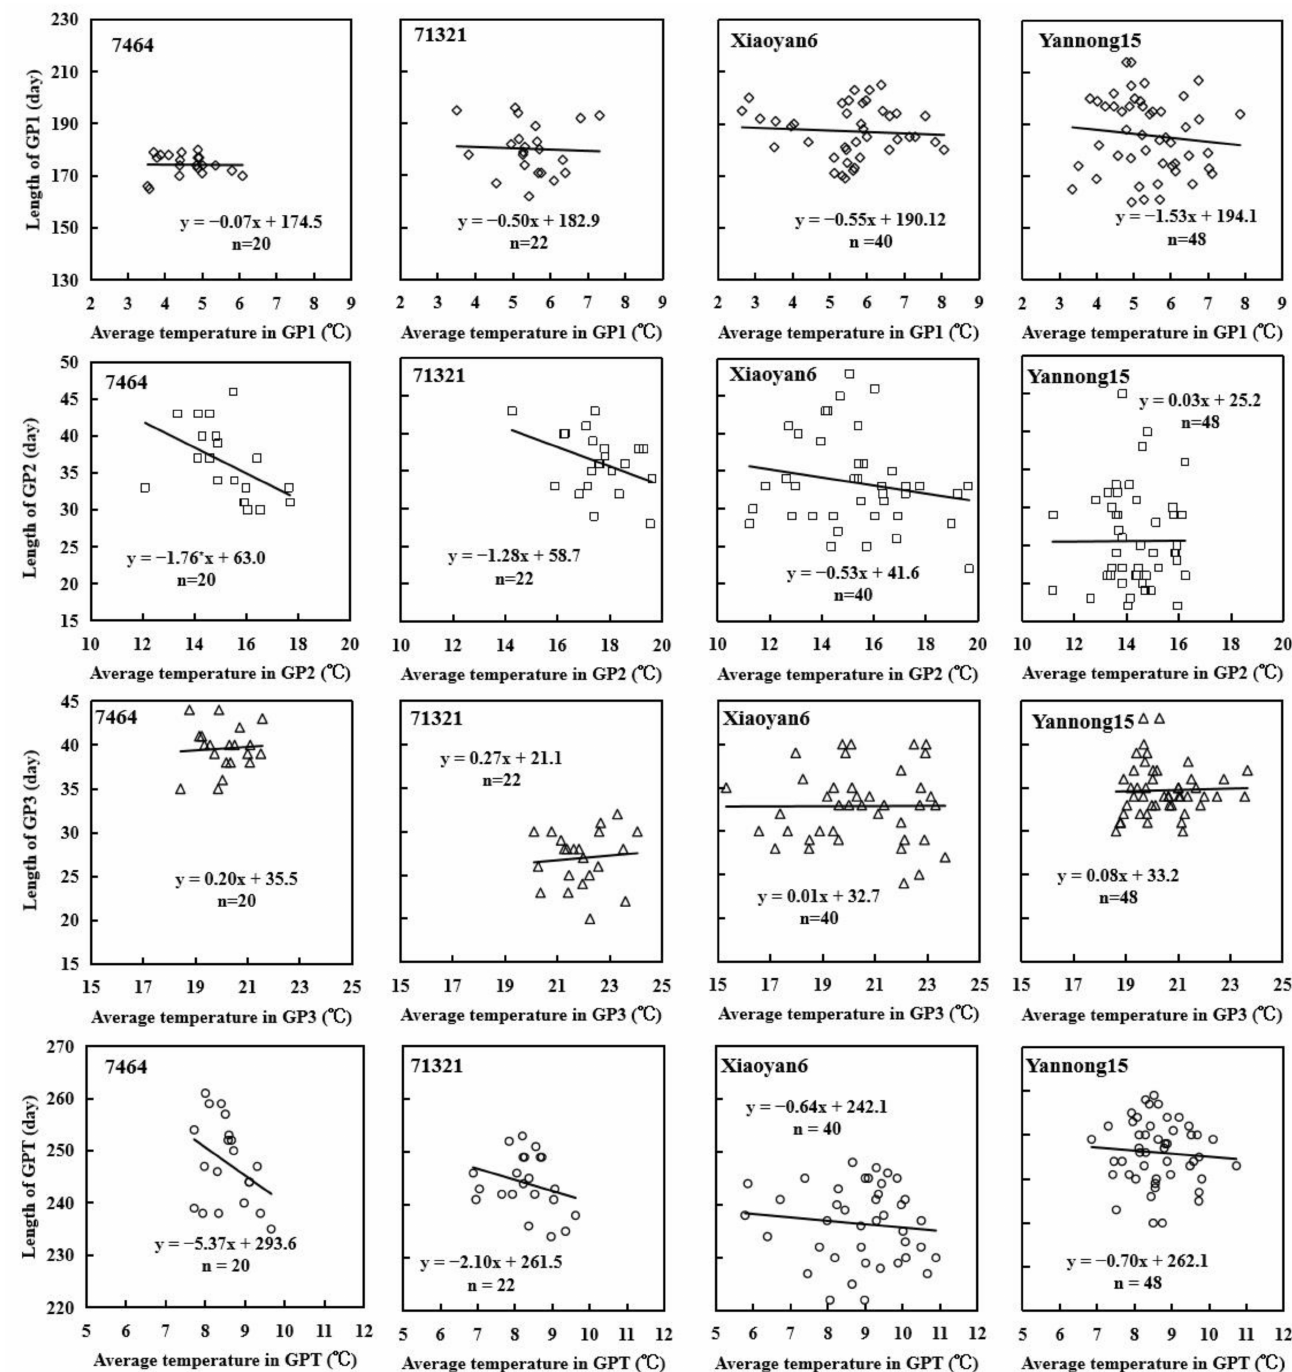
Figure 3. Relationships between average temperatures and length of growth periods in four winter wheat cultivars, with best-fit linear regression line. Average temperatures were calculated from daily values during different growing durations. n represents number of samples. GP1, GP2, GP3 and GPT represent the length of growth periods from sowing to jointing, jointing to anthesis, anthesis to maturity and sowing to maturity,